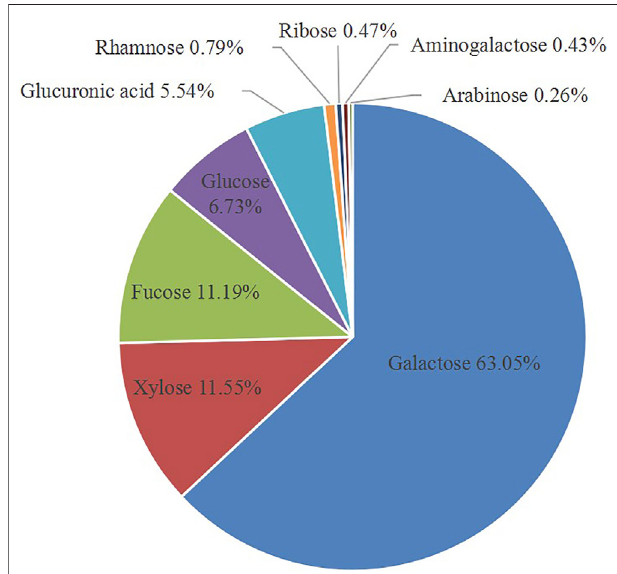
FIGURE 1 | Monosaccharide compositions of GNP were determined by the method of PMP (1-phenyl-3-methyl-5-pyrazolone) pre-column derivatization combined with high-performance liquid chromatography